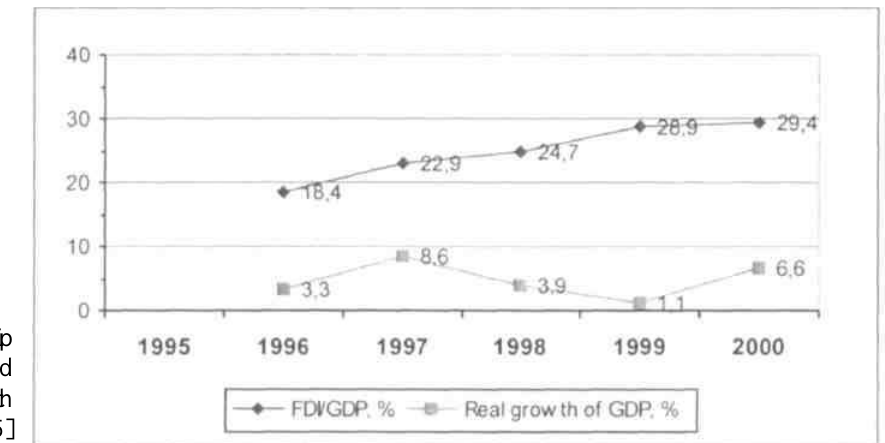
Fig 2. Analysis of Relationship Between Growth of FDI Measured as FDI/GDP, (%) and Real Growth of GDP, (%) in Latvia